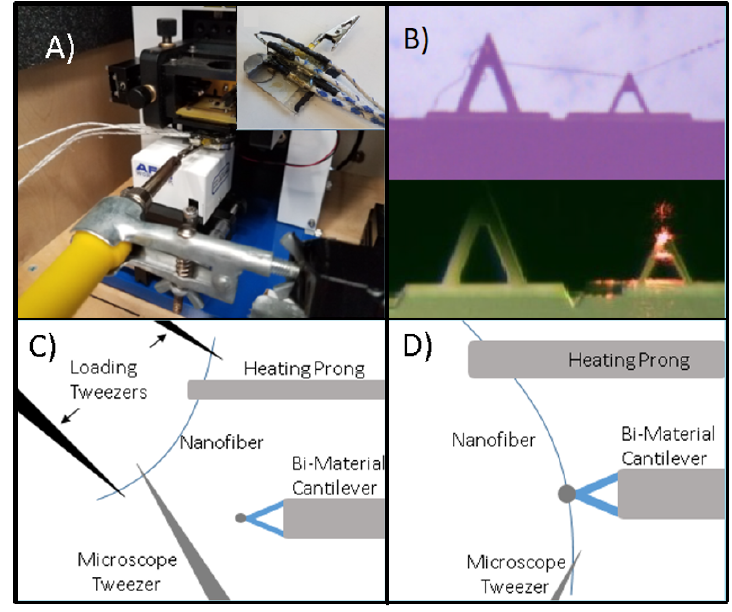
Figure 2. Experimental setup of ( A ) AFM sample plate when inserted into the AFM. Inset shows thermocouple positions on the sample plate. ( B ) Microscope image of a nanofiber appended to the bimaterial cantilever via van der Waals forces (top) and the calibration image of the cantilevers in the AFM (bottom). ( C ) Collecting the nanofiber from the electrospinning apparatus for appendage to the measurement apparatus. ( D ) Nanofiber appending itself to the bimaterial cantilever via van der Waals forces